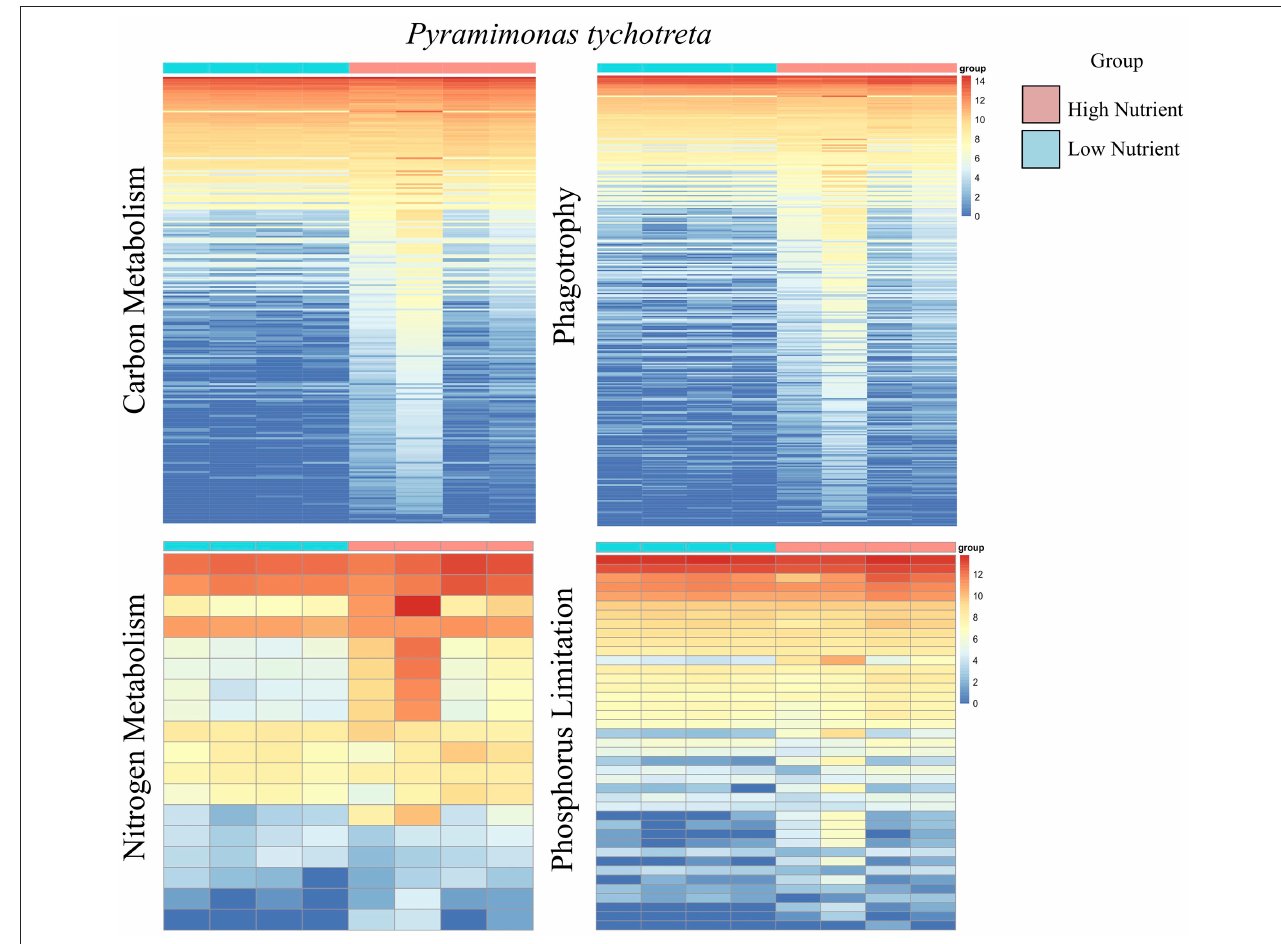
FIGURE 5 | A series of heatmaps for Pyramimonas tychotreta comparing gene expression associated with carbon (C) metabolism, nitrogen (N) metabolism, phagotrophy and phosphorus (P) limitation, in cultures grown under high nutrient vs. low nutrient conditions. Tiles represent log-normalized count estimations of transcripts. Genes for C metabolism, N metabolism, and phagotrophy were identified by KEGG and categories were selected based on BRITE hierarchies, except P limitation genes, where genes were selected based on genes identified by Rouached et al.